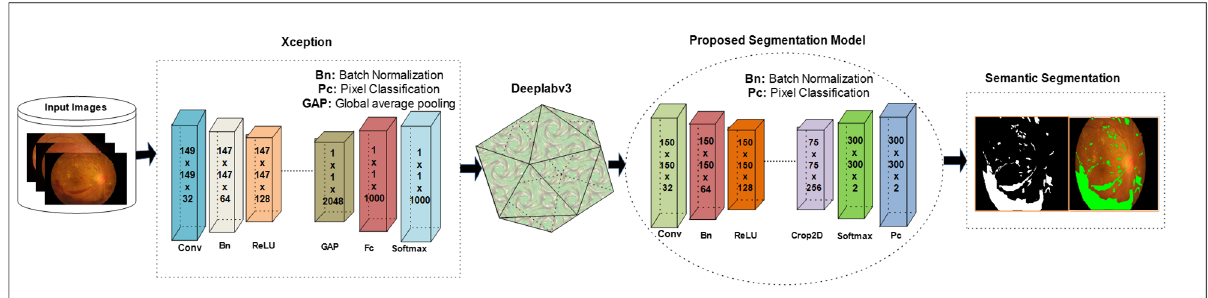
Figure 3. Proposed model for NPDR lesion segmentation.